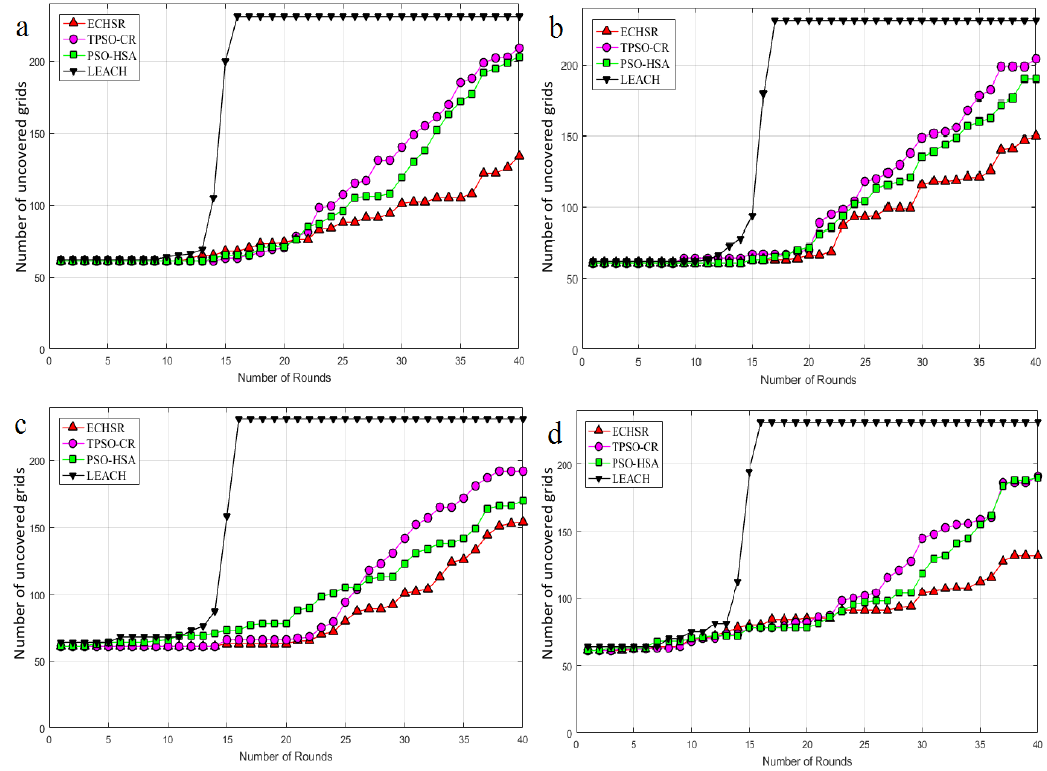
Figure 12. Network coverage for sink locations ( a ) (100, 100), ( b ) (0, 100), ( c ) (50, 150), and ( d ) (50,